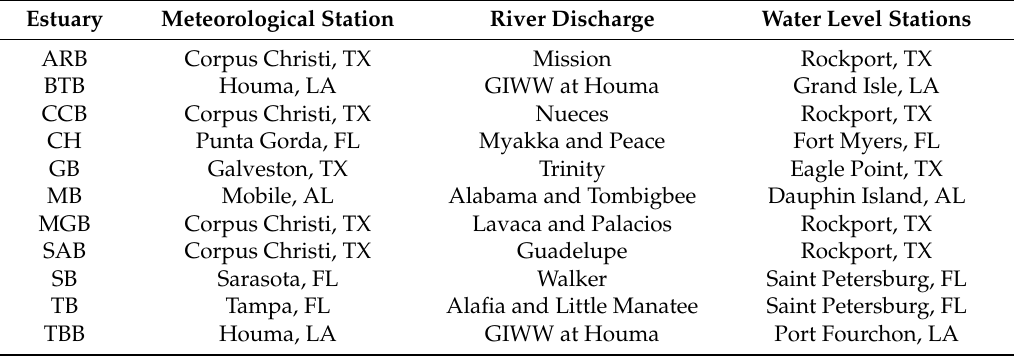
Table 2. Station locations used for meteorological, river discharge, and water level data for each